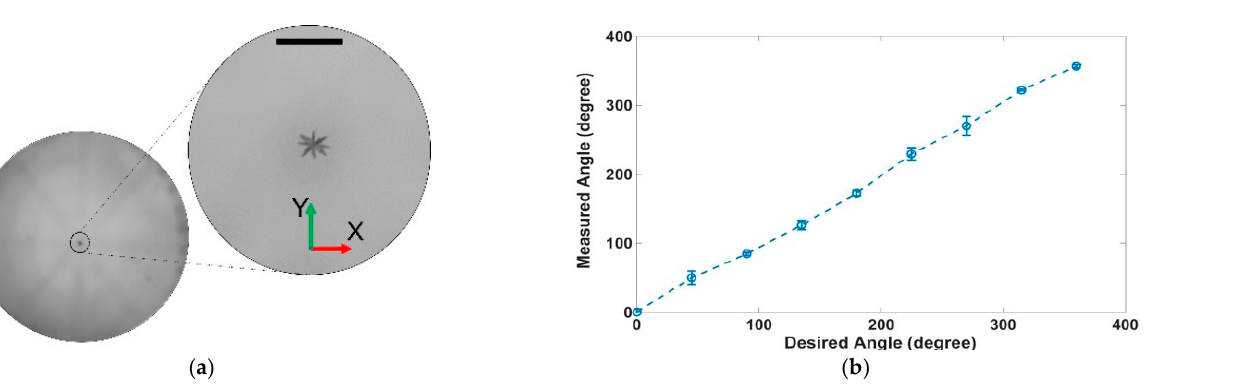
Figure 10. Demonstration of rotation control in the O-XY plane: ( a ) time-lapse image sequences show a nanocarrier cluster in the O-XY plane (viewed from above) rotated at an arbitrary location in space (scale bar is 1 mm); ( b ) difference angle between the measured and desired angles in open-loop control. Second, the rotation of the NCs along the X -axis was demonstrated in the XOZ plane and viewed from the front of the array. The result reveals that the maximum angle was achieved at − 30.31 ◦ and 29.93 ◦ in the counterclockwise and clockwise directions,